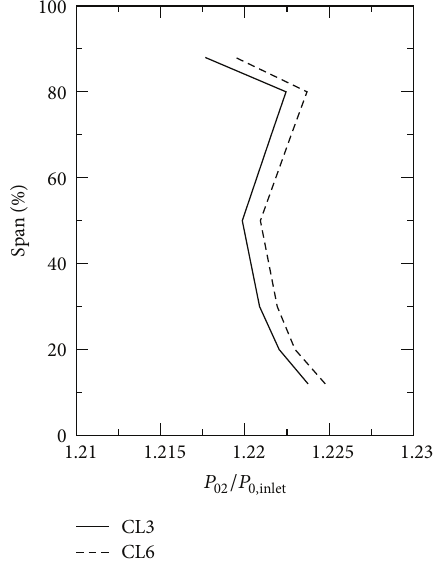
Figure 5: Radial total pressure profiles at the rotor exit for both clocking configurations.